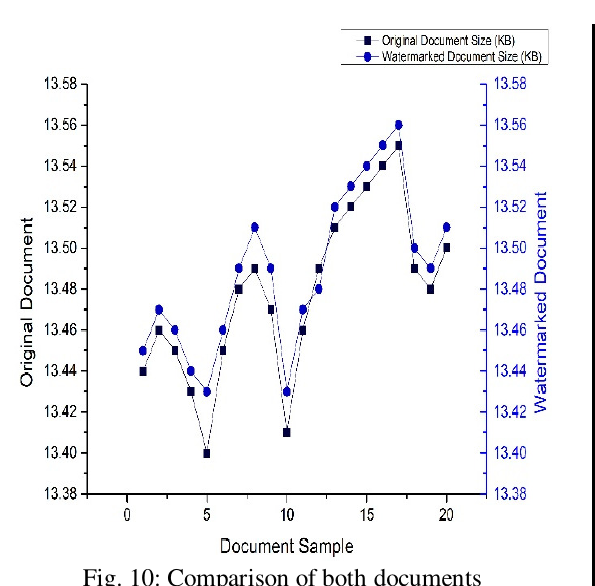
Fig. 10: Comparison of both documents